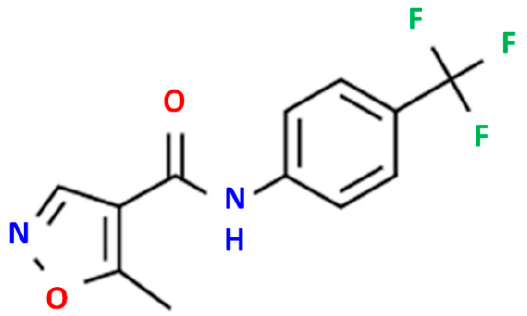
Figure 1. LDF chemical structure.